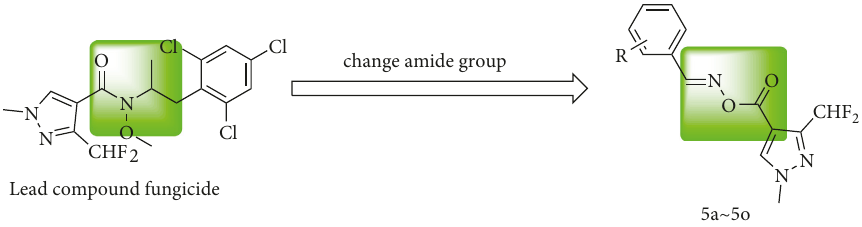
Figure 1: Design strategy of pyrazole oxime ester compounds 5a ∼